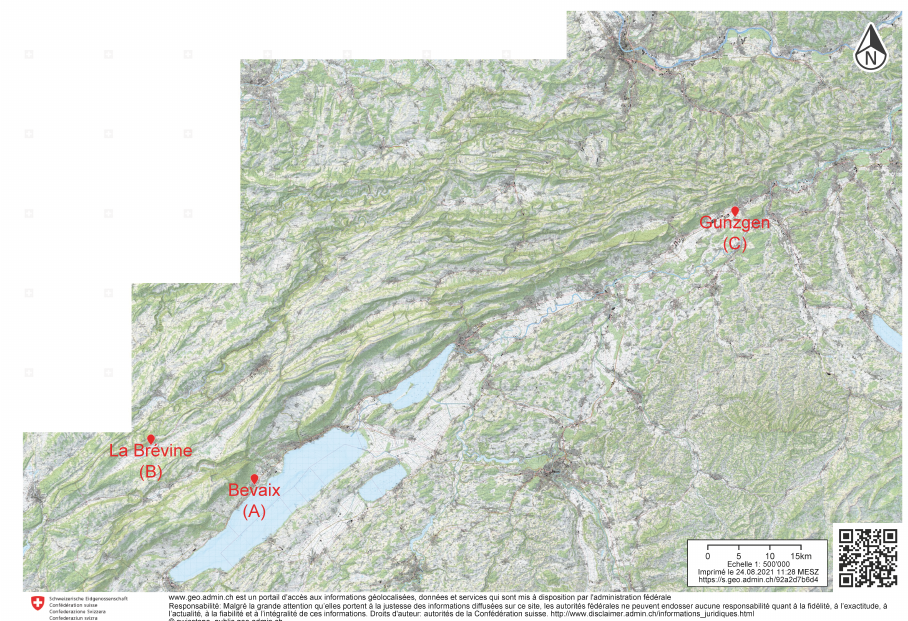
Figure A1. Map of the three study sites: Bevaix (A), La Brévine (B), Gunzgen